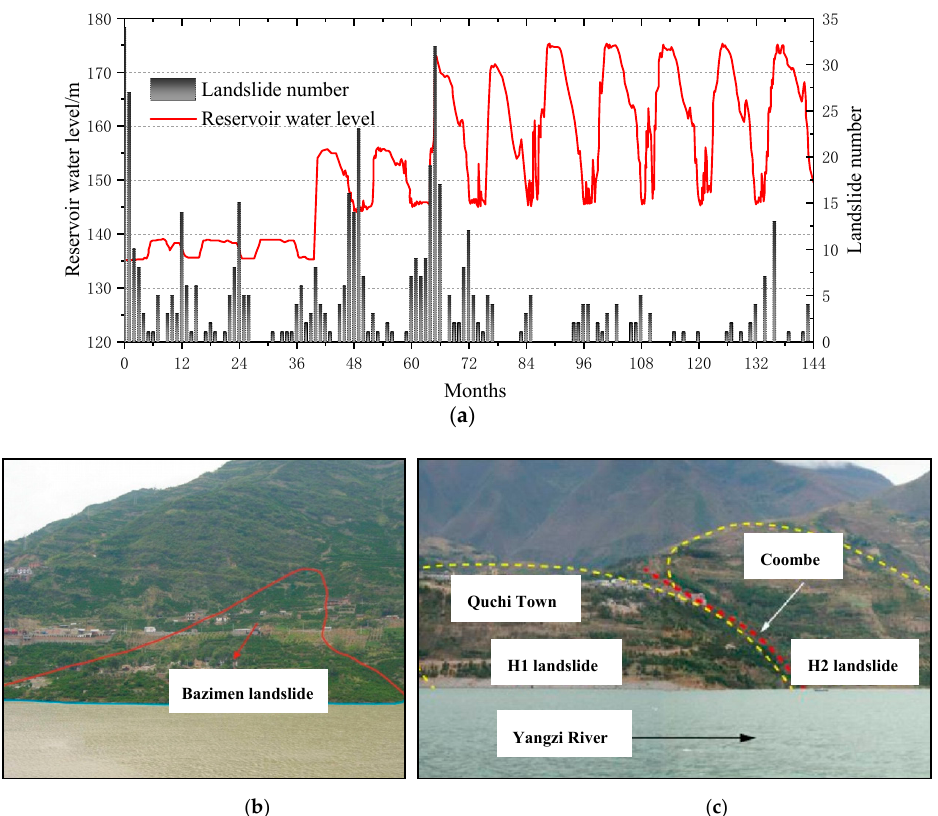
Figure 1. Reservoir water level fluctuations, landslide numbers, and typical landslide diagram. ( a ) Bazimen landslide [10]. ( b ) Taping landslide [11]. ( c ) Taping landslide [11].